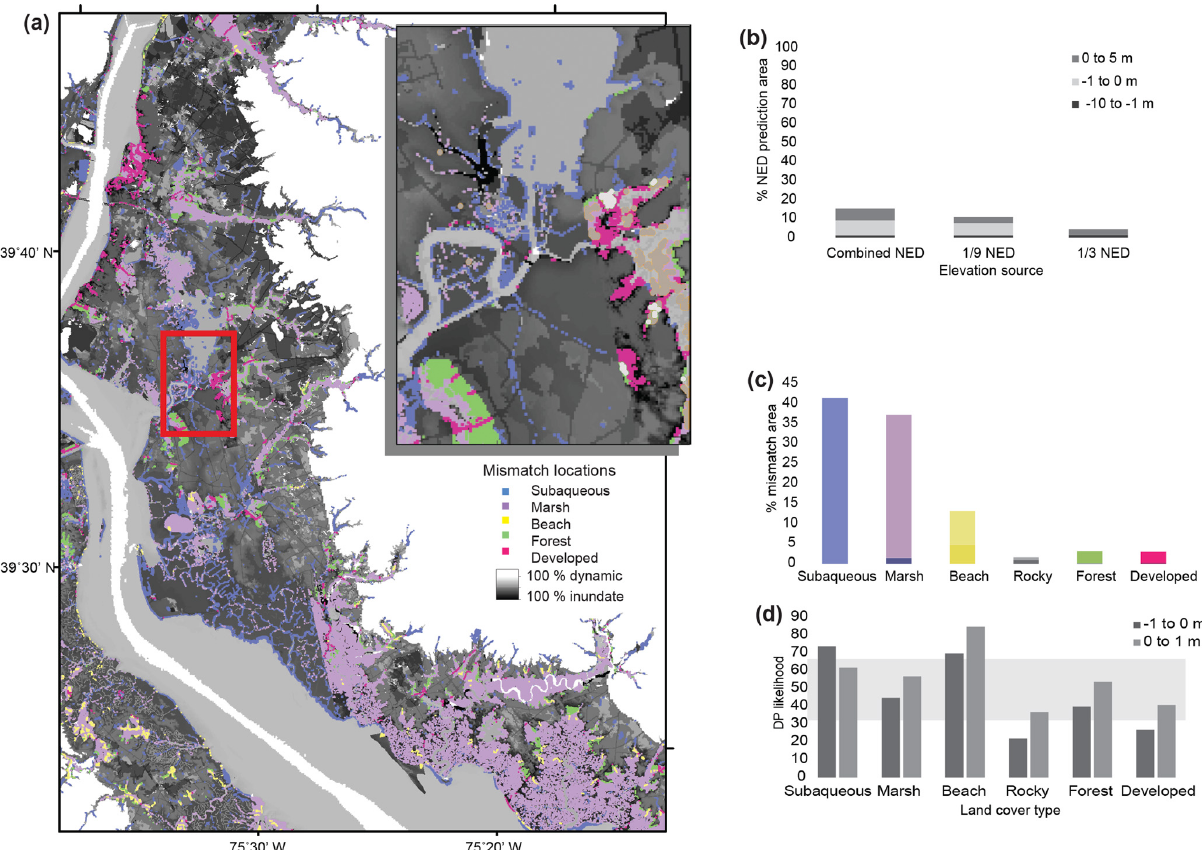
Figure 2. Results of mismatch analysis (a) in a selected area with inset of enlarged view; (b) shown as a percentage of the prediction area within the 1 / 3 National Elevation Dataset (NED) contour boundary and by elevation source type; (c) by land cover type as a percentage of the total mismatch area, where lighter hues show the percent of predictions in the − 1 to 0m range (with the exception of subaqueous, which shows a 0 to 1m range), and darker hues show the percent of predictions in the − 10 to 1m range; and (d) the corresponding probability of dynamic response (DP) likelihood for each land cover type in the elevation ranges most commonly mistaken (light gray box shows the as likely as not likelihood range (0.33> P >0.66) following Mastrandrea et al.,